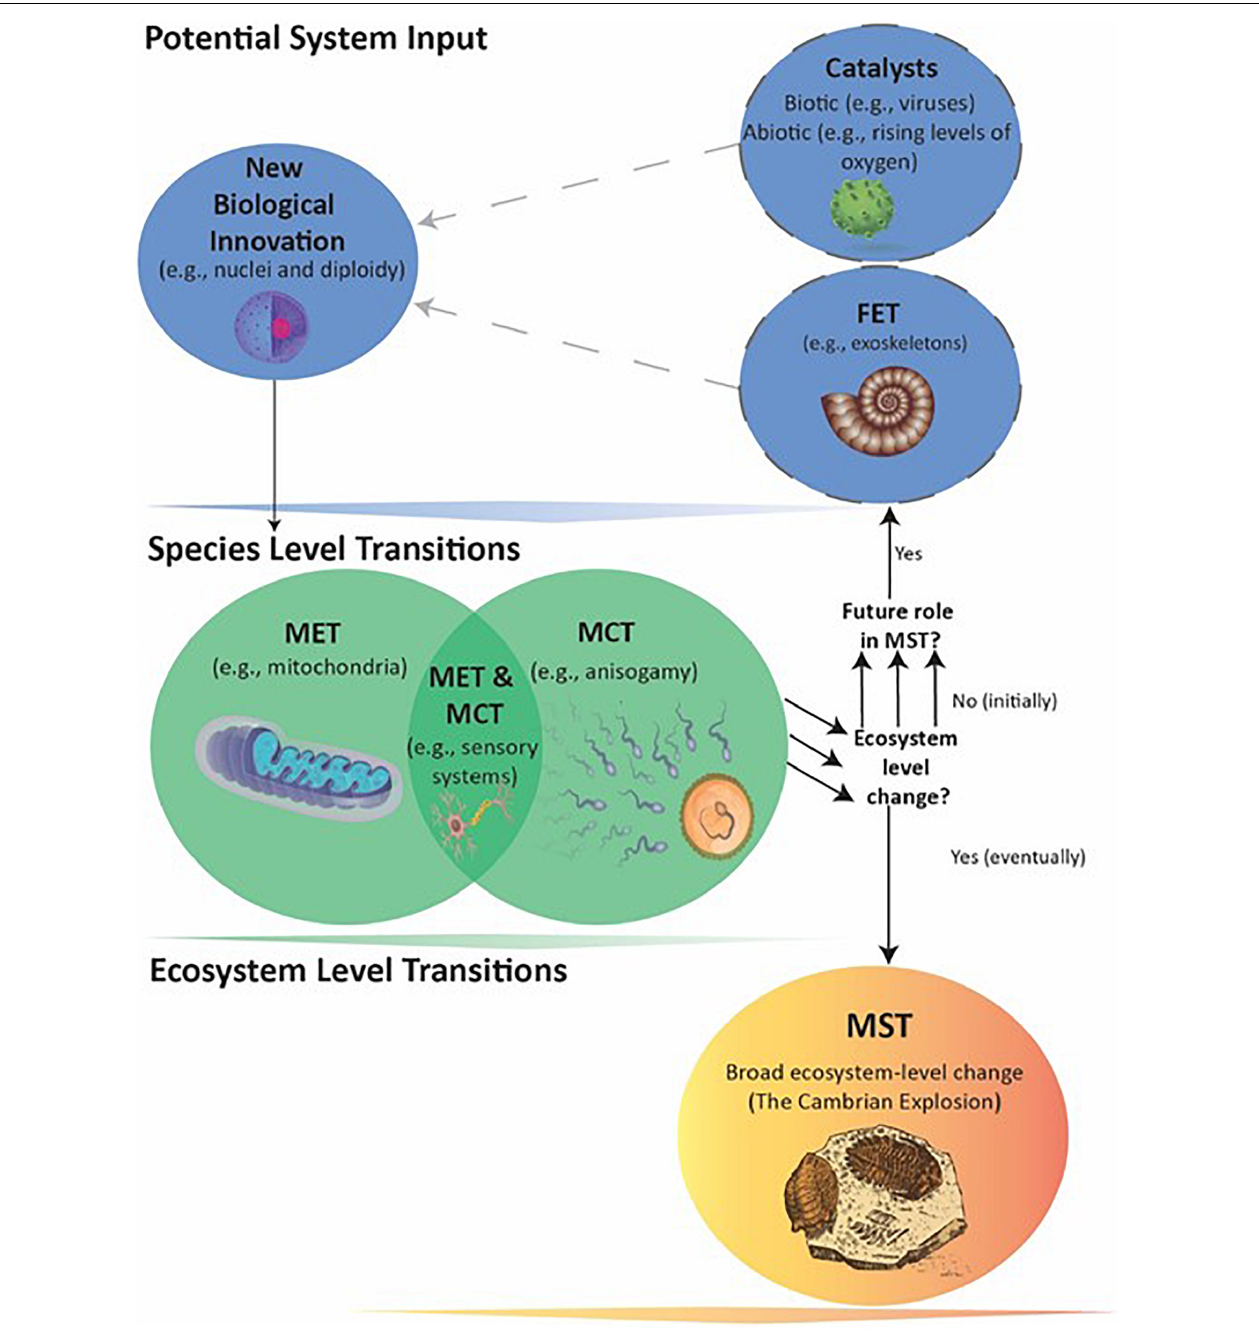
FIGURE 2 | Events leading to the Cambrian MST. The transitions from prokaryote to large eukaryotes with tissues and organs likely involved multiple Fusions and Information Leaps, MCTs, and catalytic agents and events. The multiple arrows indicate that a number of separate Species-level transitions created multiple FETs that eventually made the Ecosystem-level MST possible. The exact order in which the FETs evolved is not conclusively known (see